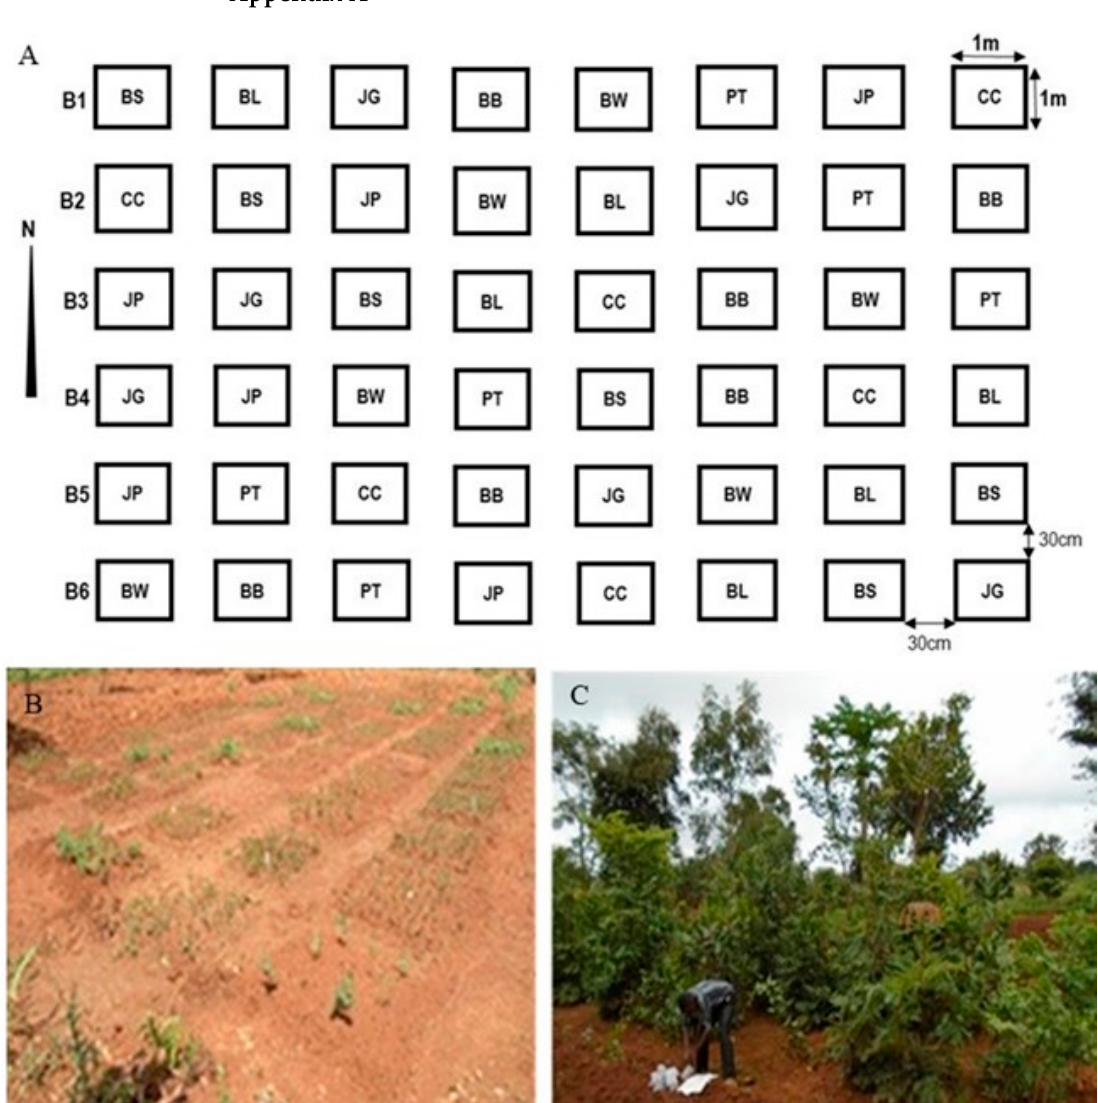
Figure A1. Experimental design ( A ), seedlings at three months ( B ) and at four years of age ( C ) for tree species of woodland. CC: C. collinum and PT: P. tinctorius (Early successional species), BB: B. boehmii , BL: B. longifolia , BS: B. spiciformis , BW: B. wangermeana , JG: J. globiflora and JP: J. paniculata (Late successional species). B1 to B6: linear blocks. Table A1. Pearson correlations between survival and growth of seedlings of woodland trees, 9 months after planting. RCD: diameter of the stem at collar level, RD: diameter of the root at 15 cm from collar level; SH: height of the stem and RL: the root length. ***: p ≤ 0.001; **: p ≤ 0.01 and ns: not significant ( p > 0.05).